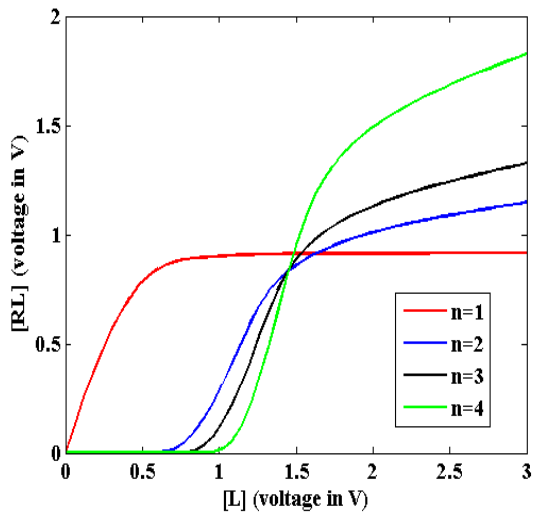
Fig. 6: Cadence simulation results for Hill Process obtained from The equivalent Electronic Circuit shown in Fig. 2, illustrating the effect of changing Hill Coefficient n